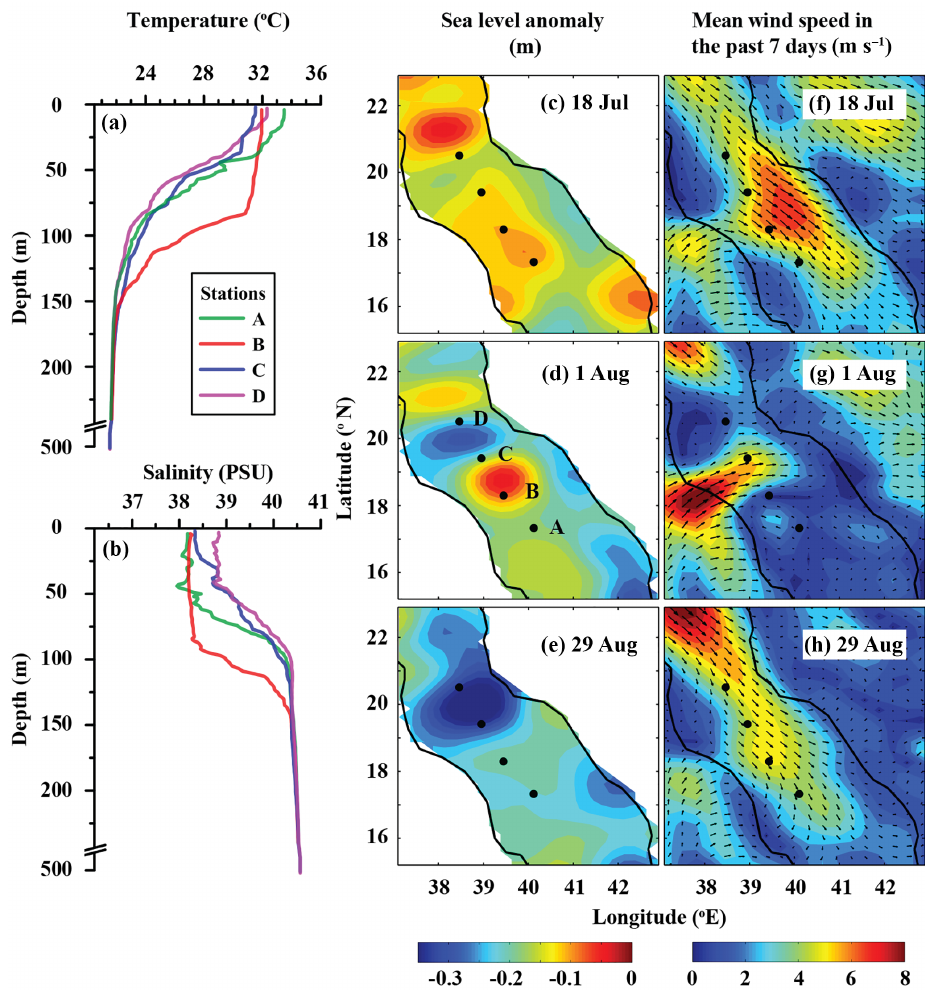
Figure 8. (a) The CTD-measured temperature and salinity profiles during 13–14 August 2001. (b) SLA maps and (c) wind speed and direction (averaged for the previous 1 week) in the Tokar region before, during, and after the Tokar event. The temperature and salinity profiles are received through personal communication from Sofianos and Johns